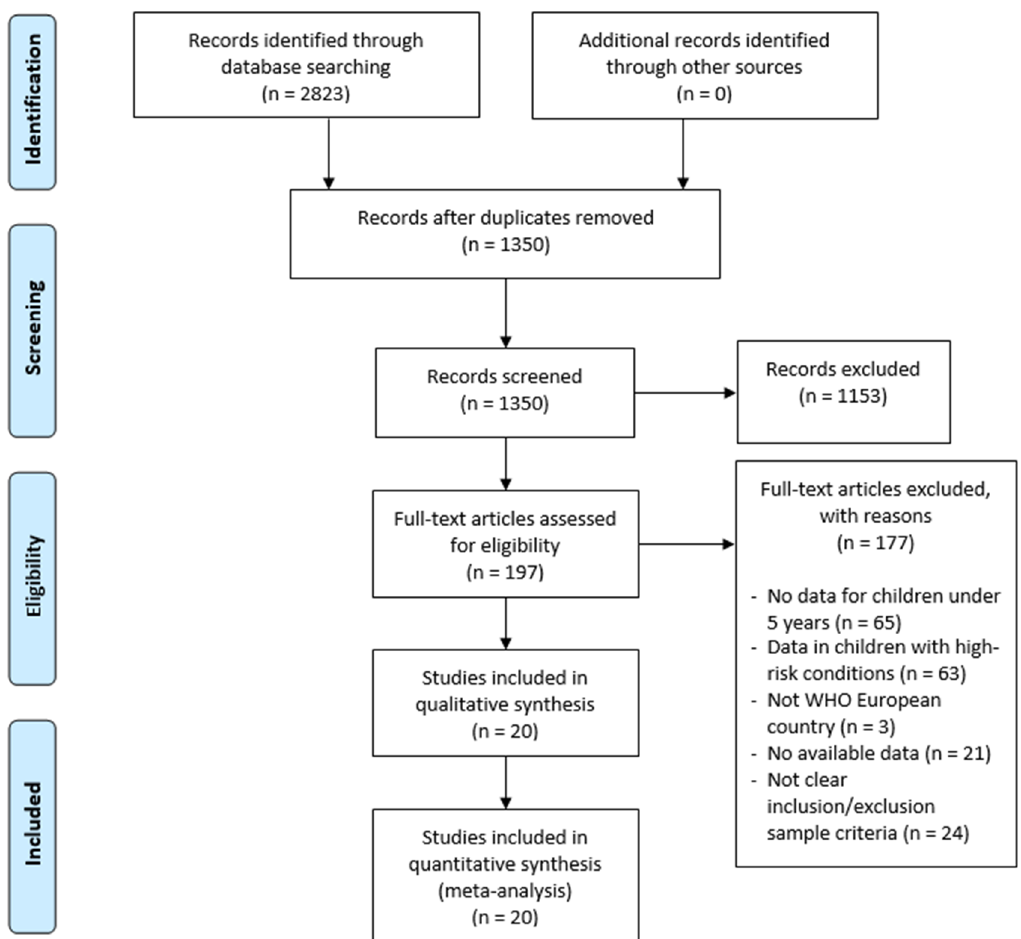
Figure 1. Flow diagram of the selection process.